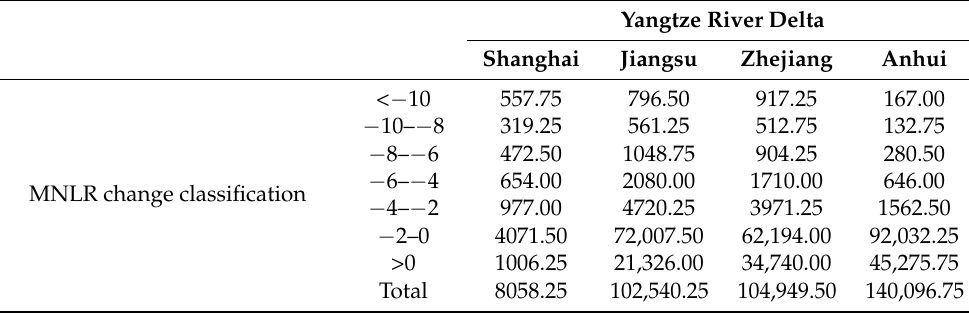
Table 1. Statistics of MNLR change classification area in April 2022 of Yangtze River Delta (km 2 ). Yangtze River Delta Shanghai Jiangsu